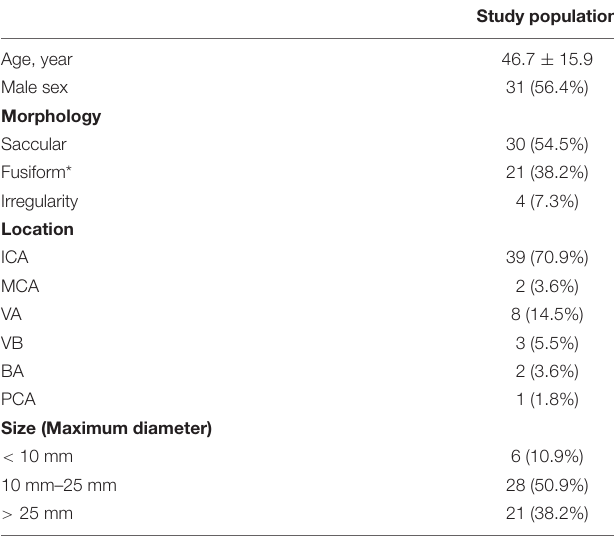
TABLE 1 | Baseline patient and aneurysm